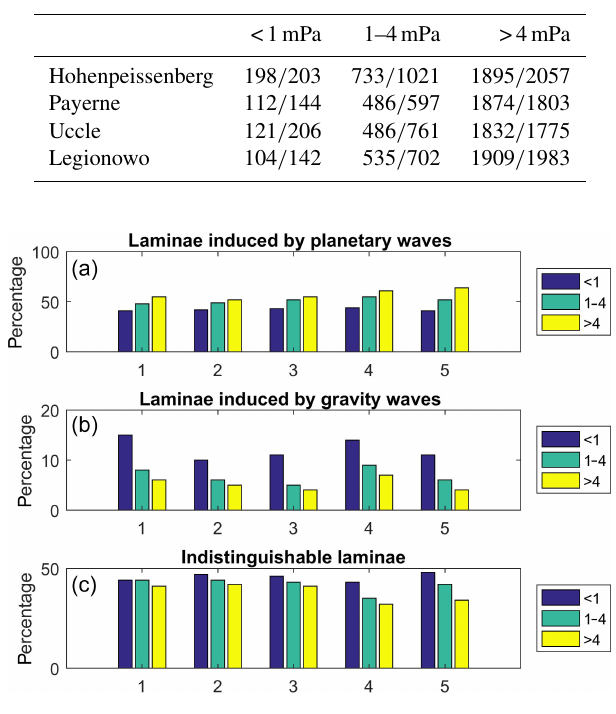
Figure 7. The dependence of the lamina composition on a lamina size for PL (a) , GL (b) , and indistinguishable laminae (c) at the European stations (1 – Payerne, 2 – Uccle, 3 –